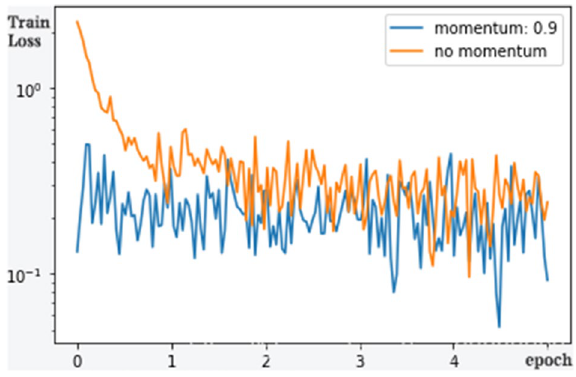
Fig. 8 Momentum contrast experiment